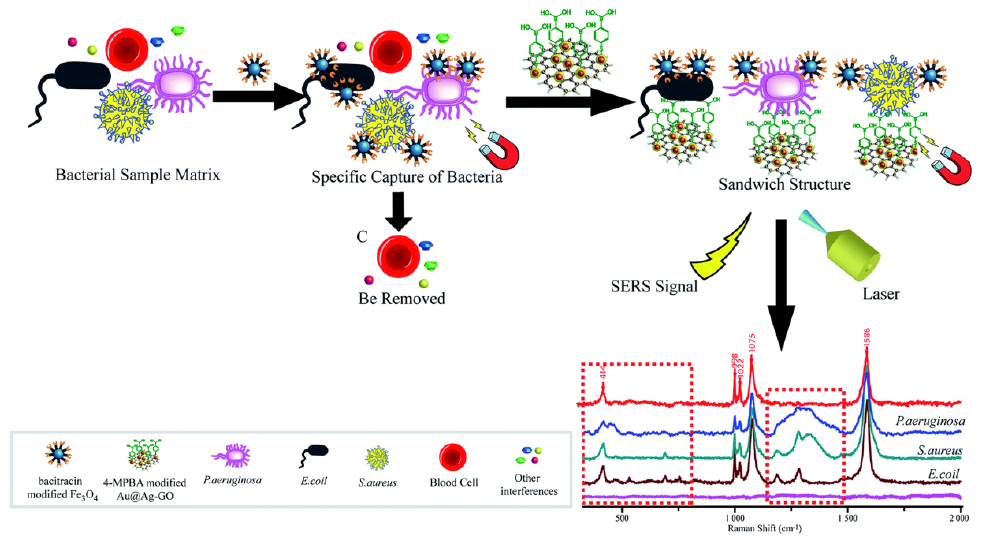
Figure 21. Bacterial detection via a SERS sandwich strategy, in which AMP modified magnetic Fe 3 O 4 NPs were utilized in the bacteria capture and 4-MPBA modified Au@Ag-GO nanocomposites were used as SERS tags. Adapted from [266] with permission.